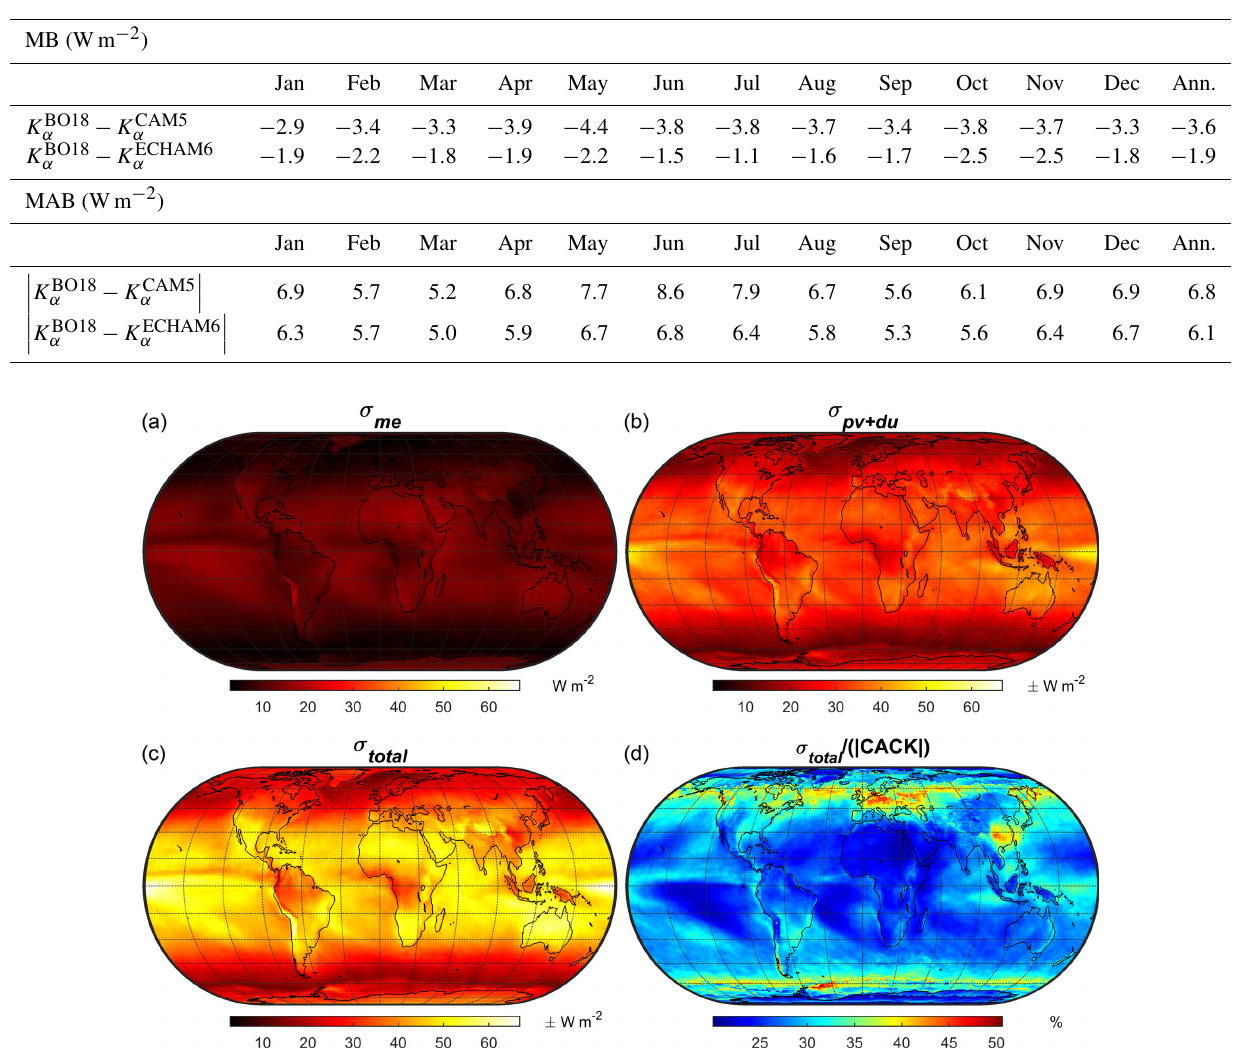
Table 4. Global monthly mean bias (MB) and mean absolute bias (MAB) for K BO18 α emulated with T and SW SFC ↓ from ECHAM6 and CAM5. For reference, the global mean value of K BO18 α is 133Wm − 2 .